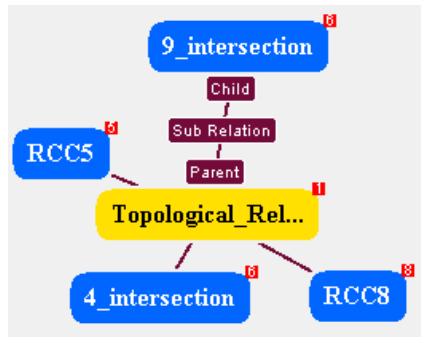
Figure 3. Topic map of spatial topological relation